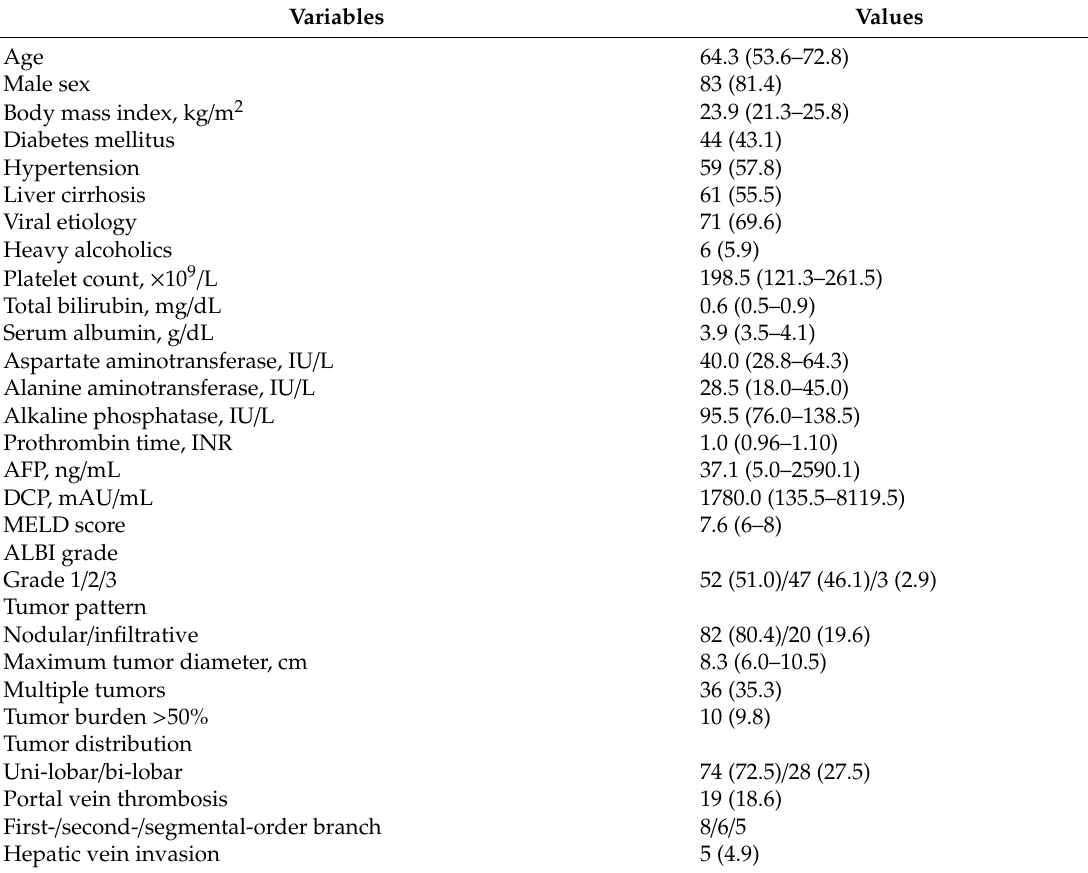
Table 1. Baseline characteristics of the study population ( n =